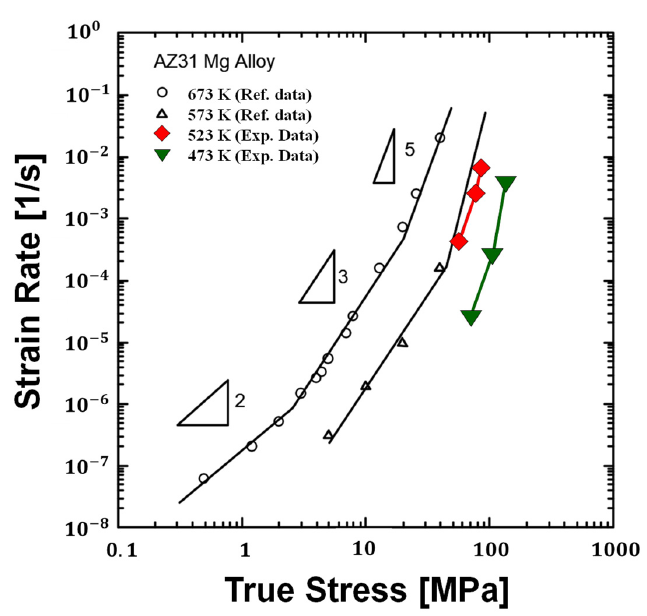
Figure 15. Steady state strain rate against stress for specimens. The reference data was obtained from Chung and Kim [26].